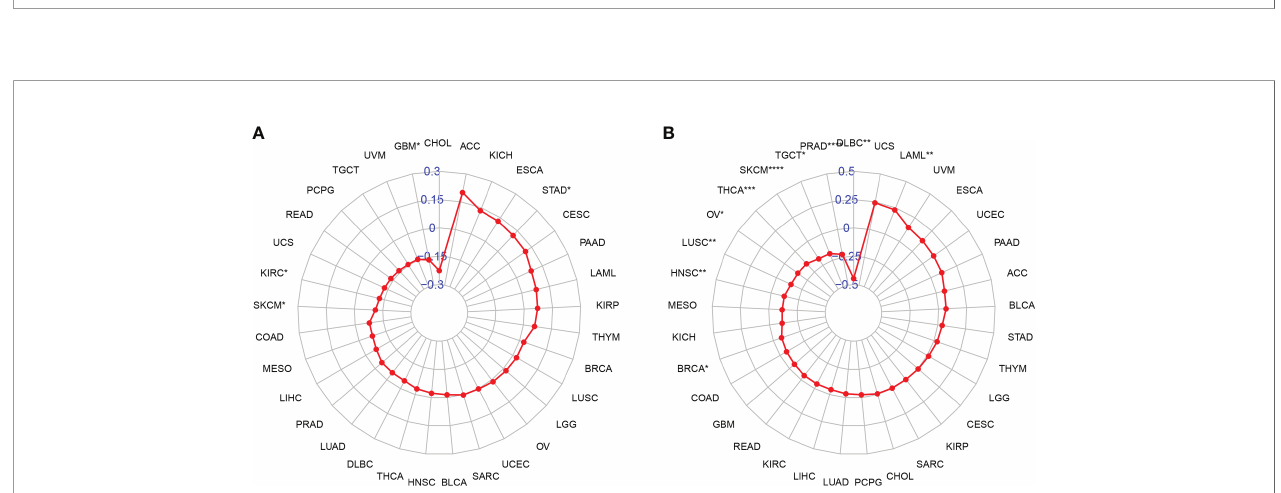
FIGURE 11 | Relationship of NAAA expression and tumor mutational burden (TMB), microsatellite instability (MSI). (A) Radar map illustrating the relationship between NAAA expression and TMB. (B) Radar map illustrating the relationship between NAAA expression and MSI. The red lines represent correlation coef fi cients, and blue values represent ranges. Spearman correlation test, *p < 0.05, **p < 0.01, ***p < 0.001, and ****p <